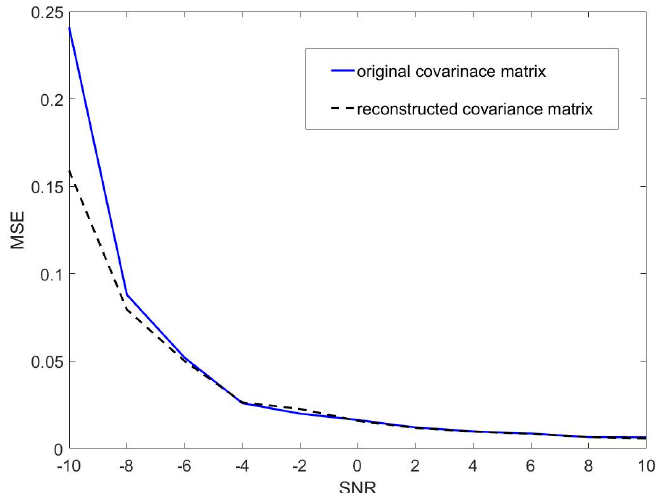
Figure 4. MSEs of the original covariance matrix R x and the reconstructed covariance matrix R xx in the environment contained noise.